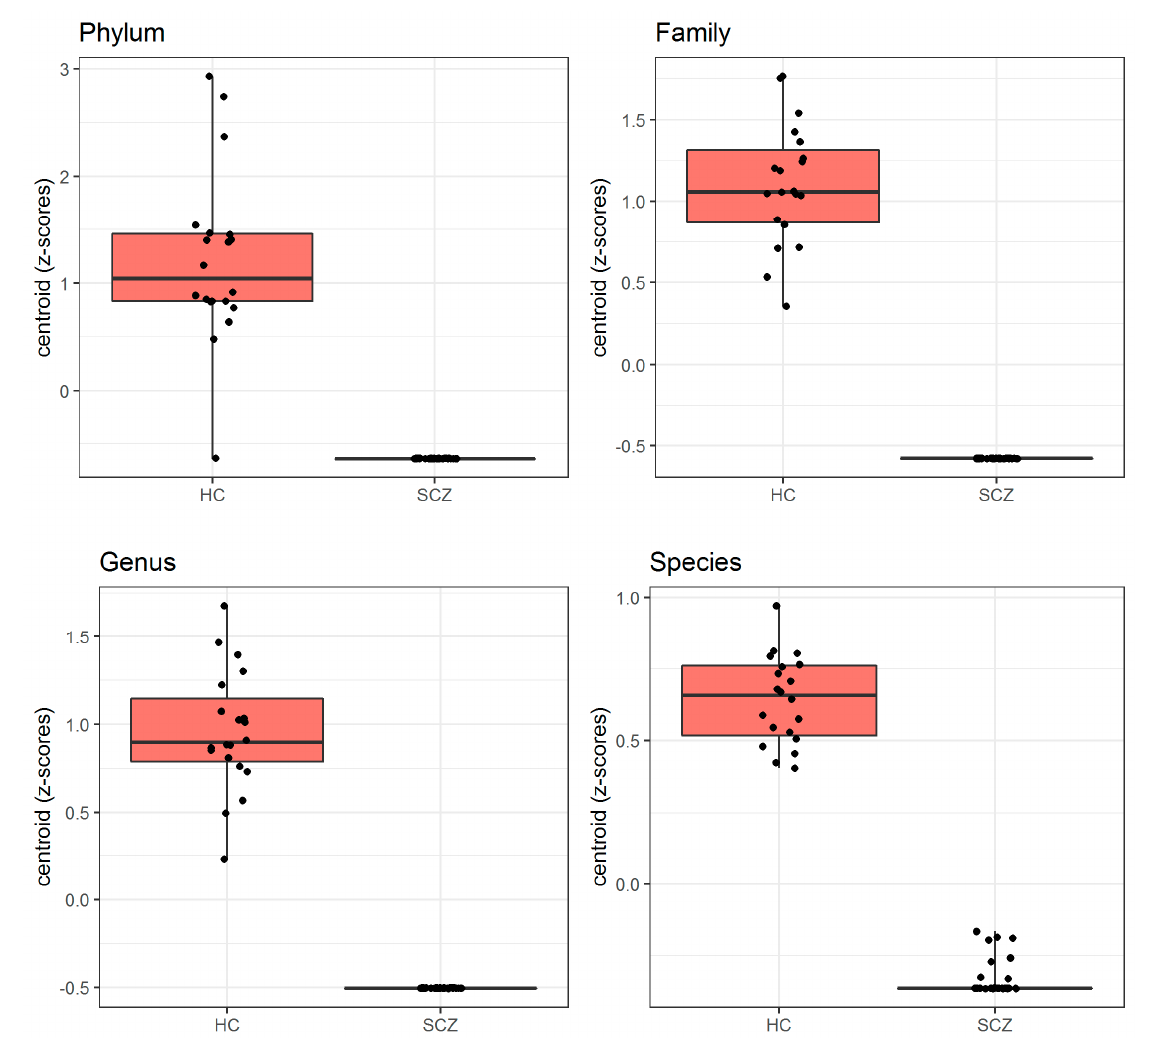
Figure 4. Boxplots of centroid Z-scores, computed by the penalized logistic regression analysis algorithm, which discrimi- nated all patients affected by SCZ from HC.